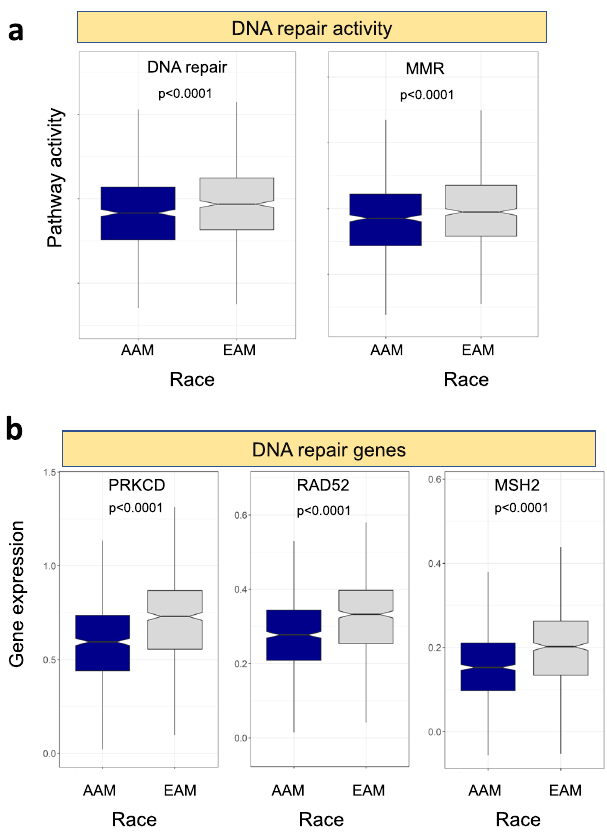
Fig. 4 Differential expression of DNA repair pathways and genes. a DNA repair activity and mismatch repair were calculated as mean of genes sets. Both showed lower activity in African Americans. b Key DNA repair genes ( MSH2 , RAD52 , and PRKCD ) were the most upregulated in patients. Error bars represent the 95% con fi dence